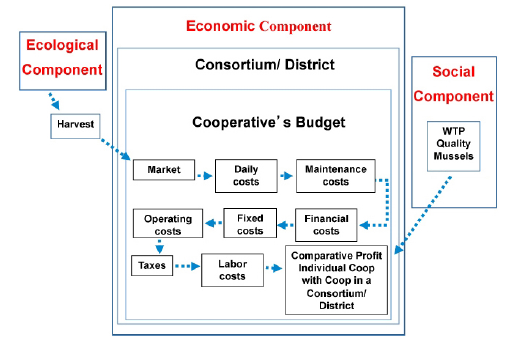
Fig. 4 . Conceptual diagram of the socioeconomic component of the simulation model. The primary link between ecological and social-economical models is the mussel harvest. The secondary link between economical and social models is the willingness to pay (WTP) for quality mussels that influences the